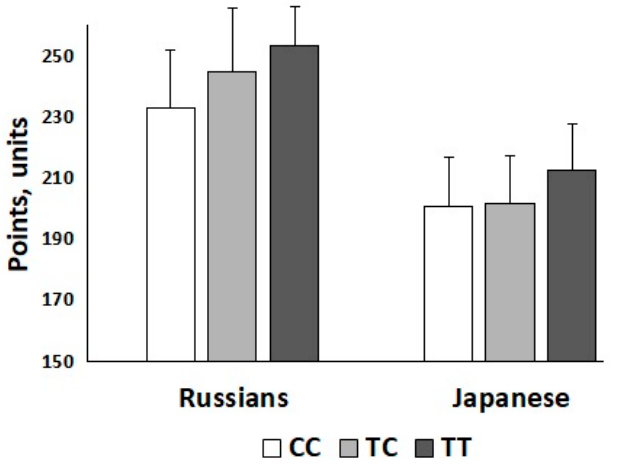
Figure 1. Weightlifting performance in elite Russian and sub-elite Japanese athletes across MMS22L rs9320823 genotypes. Statistically significant correlation was found between the number of T alleles and strength in Russian ( r = 0.33, p = 0.017) and Japanese ( r = 0.20, p = 0.047) athletes. Table 2. Genotype and allele frequencies of four SNPs in Russian ( n = 53) and Japanese ( n = 100) weightlifters.